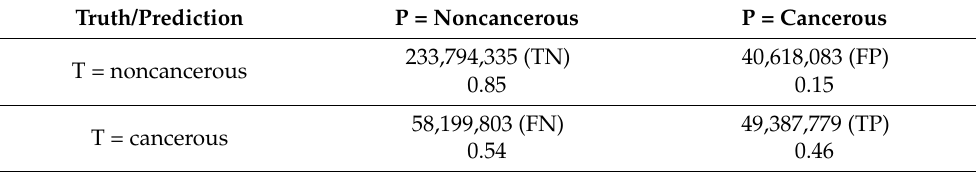
233,794,335 (TN) 0.85 58,199,803 (FN) 0.54